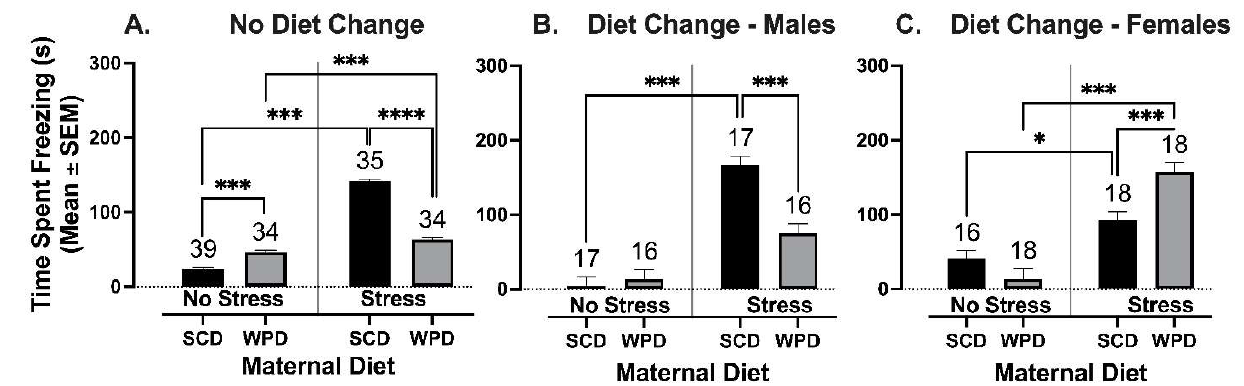
Figure 7. Total time that mice spent freezing during the OF. Freezing behavior was defined as lack of movement for ≥ 1 s. ( A ) Animals whose diets remained consistent at weaning. Data from male and female mice are pooled due to no significant main or interaction effects of sex. ( B ) Male mice whose diets were switched at weaning. ( C ) Female mice whose diets were switched at weaning. Group n ’s located above bars. WPD = western pattern diet; SCD = standard chow diet. * p < 0.05, *** p < 0.001, **** p < 0.0001.